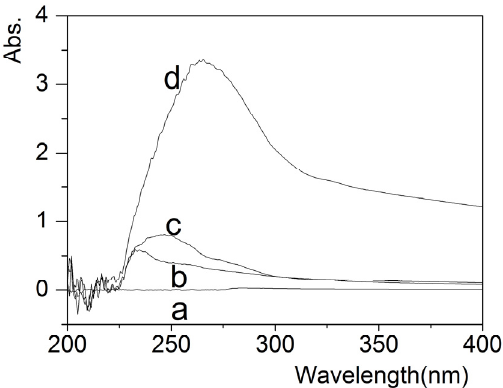
Figure 4. UV-Vis spectra of PVA/SiO 2 -TiO 2 hybrid fibers. The molar ratio of TiO 2 and